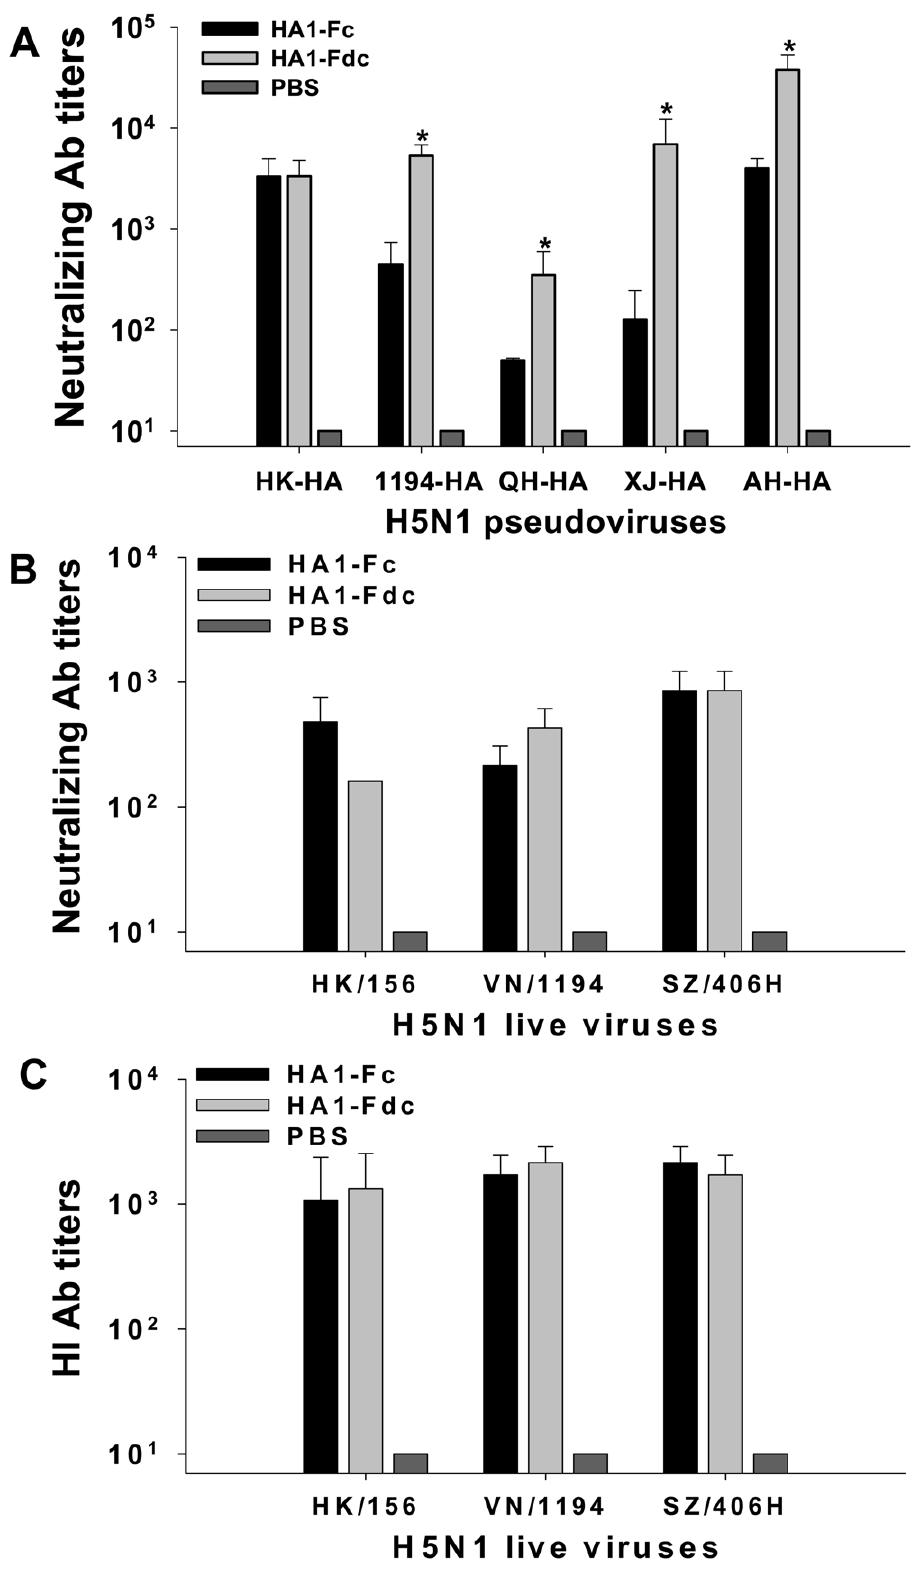
Figure 5. Assessment of neutralizing antibody and HI antibody titers in HA1-Fc- and HA1-Fdc-vaccinated mouse sera. Sera were collected at 10 days post-last vaccination. PBS was used as the negative control. (A) Neutralizing antibody titers against HA of heterologous (HK-HA, 1194-HA, QH-HA and XJ-HA) and homologous (AH-HA) strains of H5N1 pseudovirus. The data are presented as mean 50% neutralizing antibody titer (NT 50 ) 6 SD from five mice per group. * indicates significant difference ( P , 0.05) between HA1-Fc and HA1-Fdc vaccination groups. (B) Neutralizing